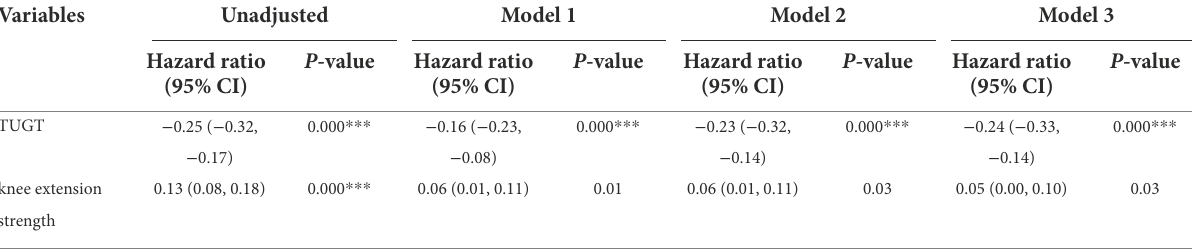
TABLE 6 Linear regression analysis of TUGT and knee extension strength on cognition